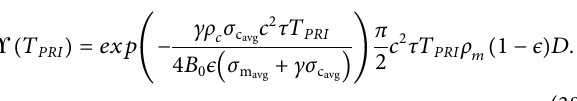
FIGURE 10 | Meta distribution of the SCNR for different SCNR